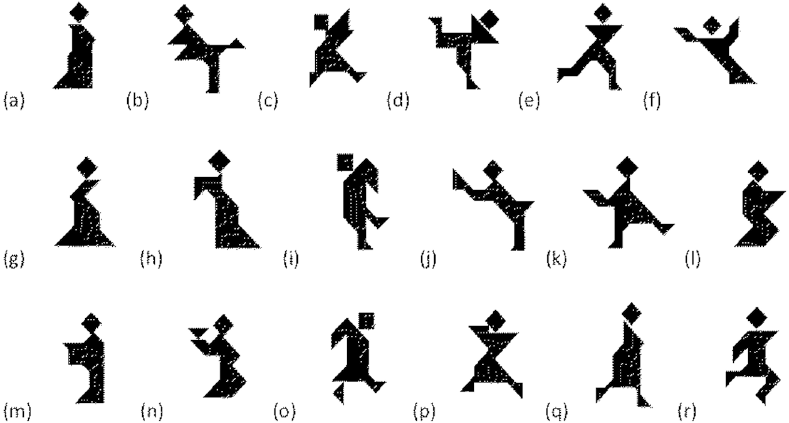
Fig 1. Abstract geometric shapes described by participants in Experiment 1 and 2 (shapes sampled from